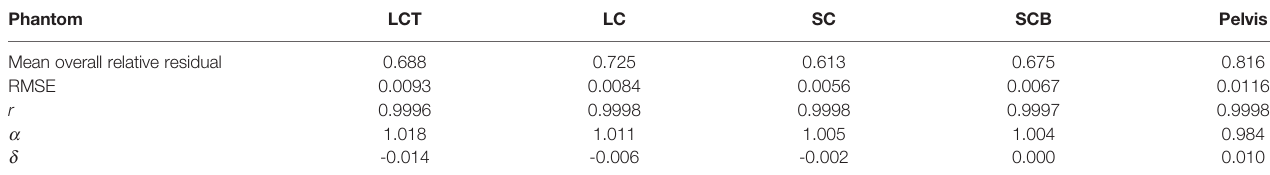
TABLE 1 | Accuracy of DLCT-based SPR predictions across fi ve different PMMA phantoms: LCT ( “ long cylinder thin ” ) phantom, LC ( “ long cylinder ” ) phantom, SC ( “ short cylinder ” ) phantom, SCB ( “ short cylinder big ” ) phantom, and a roughly human-shaped pelvis.